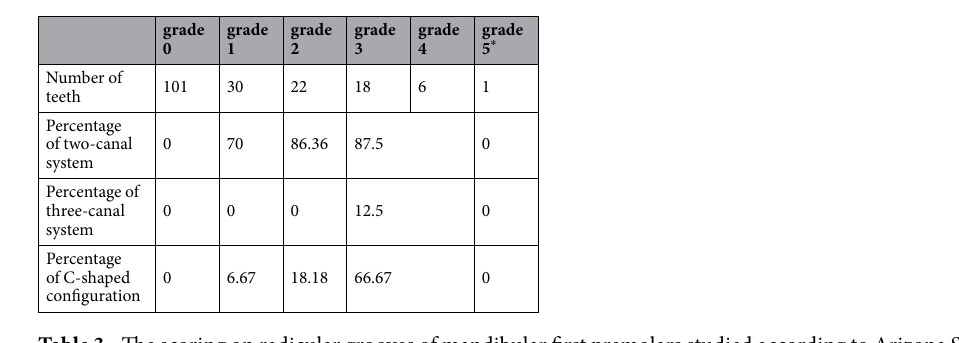
Table 3. The scoring on radicular grooves of mandibular first premolars studied according to Arizona State University dental anthropology scoring system. * The tooth (AUS = 5) has two root, each root has only single canal.